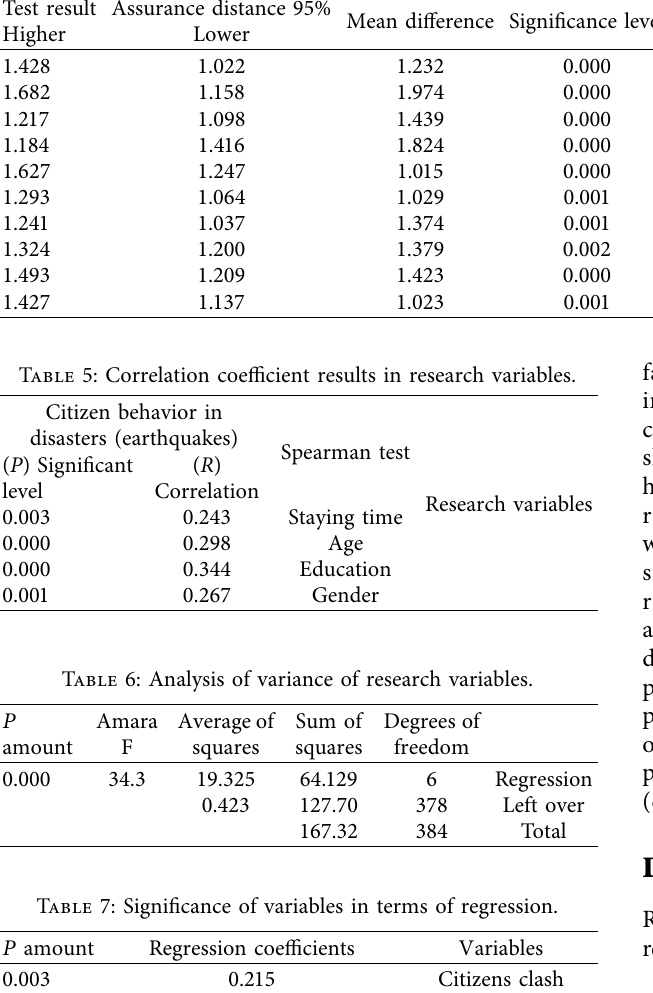
Table 4: Results of Student’s t test to evaluate the effect of physical resilience index on crisis management in natural disasters.